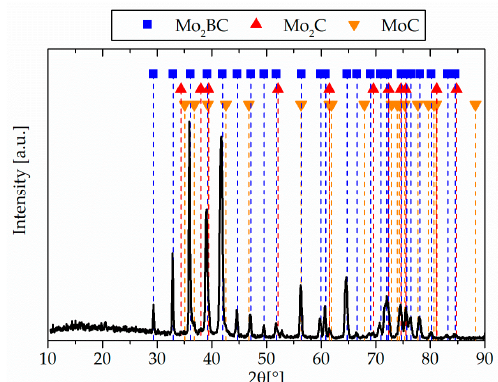
Figure 1. XRD pattern of the powder-metallurgically manufactured Mo 2 BC compound target. Small phase fractions of Mo 2 C and MoC were detected.